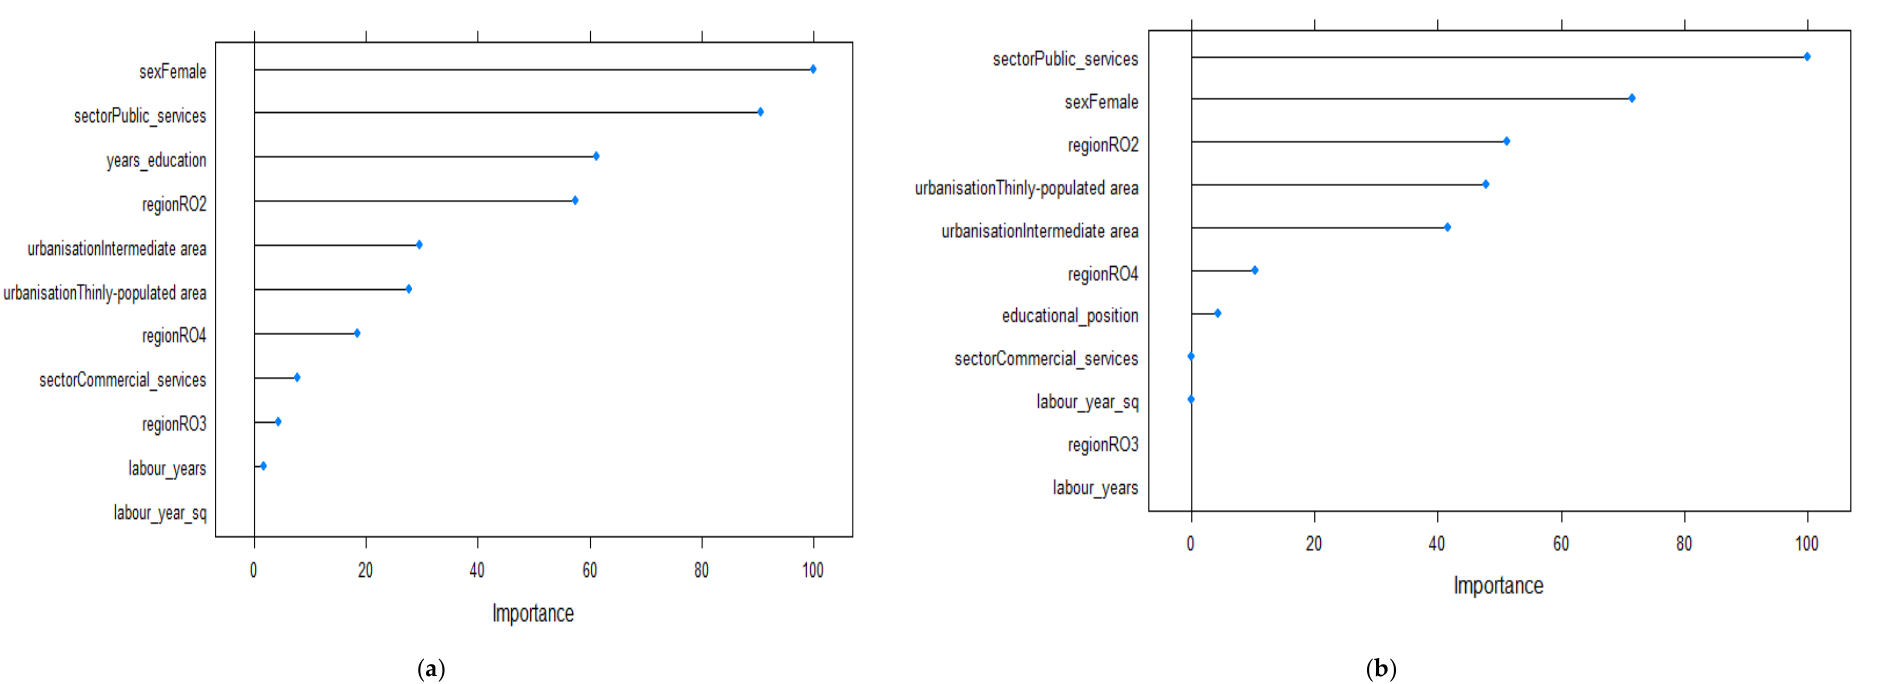
Figure 4. Relevant variables in explaining the variations in wages based on the Enet method for the 35 – 44 year old age group ( n = 1568): ( a ) model 1 using the absolute measure of education; ( b ) model 2 using the relative measure of education.